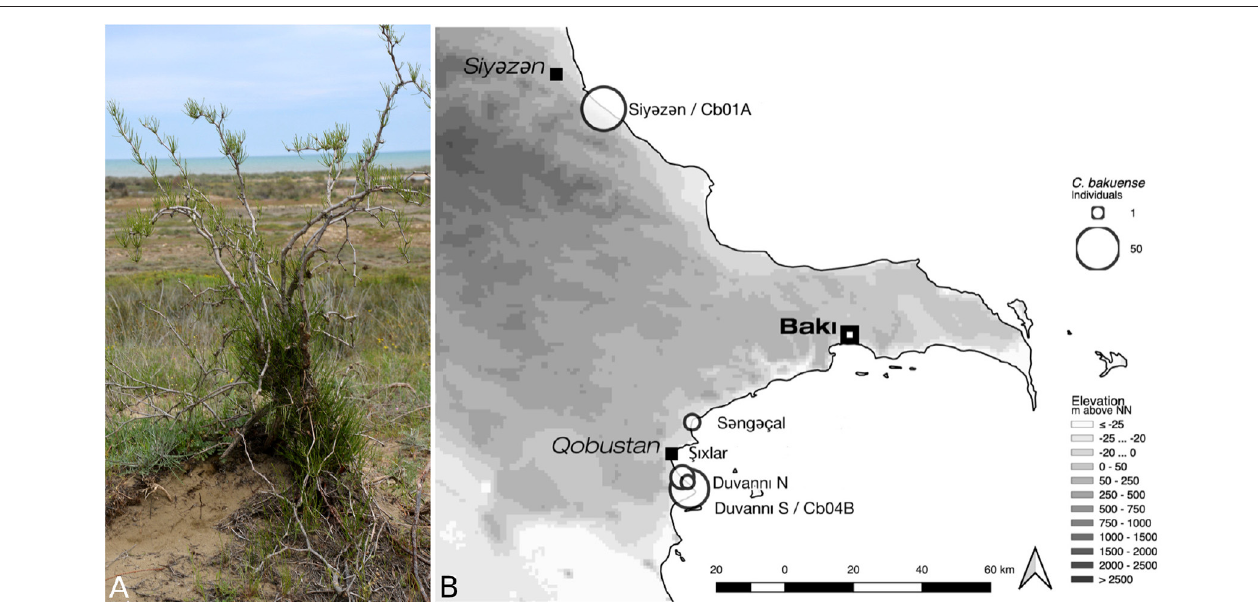
FIGURE 1 | Habit and natural environment (A) and the current distribution area (B) of C. bakuense . The map indicates the localities of all sampled natural populations of C. bakuense , including those that individuals Cb01A and Cb04B were sampled from.